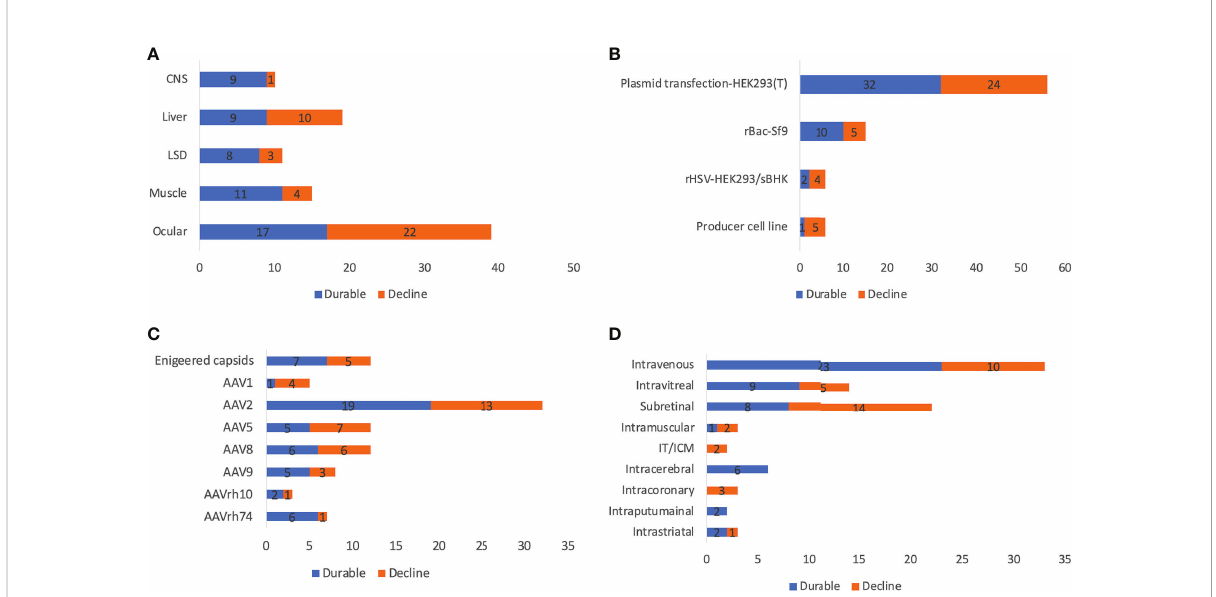
FIGURE 5 Reported durability of 255 AAV clinical trials by disease indications (A) , manufacturing systems (B) , serotypes (C) , and ROAs (D) . ROA and serotypes associated with <10 trials are not included in the fi gure. IT and ICM were combined due to the high similarity. Trials that initiated recently or did not report ef fi cacy and transgene expression data are not included for analysis.